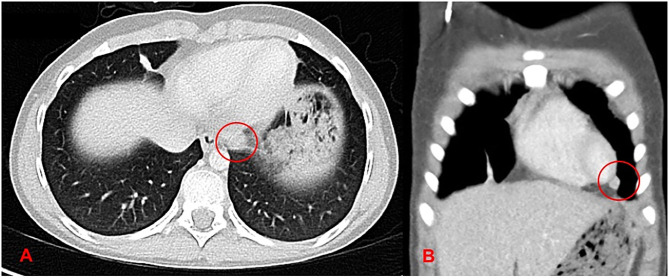
Preoperative CT revealing multiple metastases: (A) shows a paraesophageal metastasis (red circle) and (B) demonstrates a pericardial metastasis (red circle). Both were removed surgically during initial resection (Patient #13).